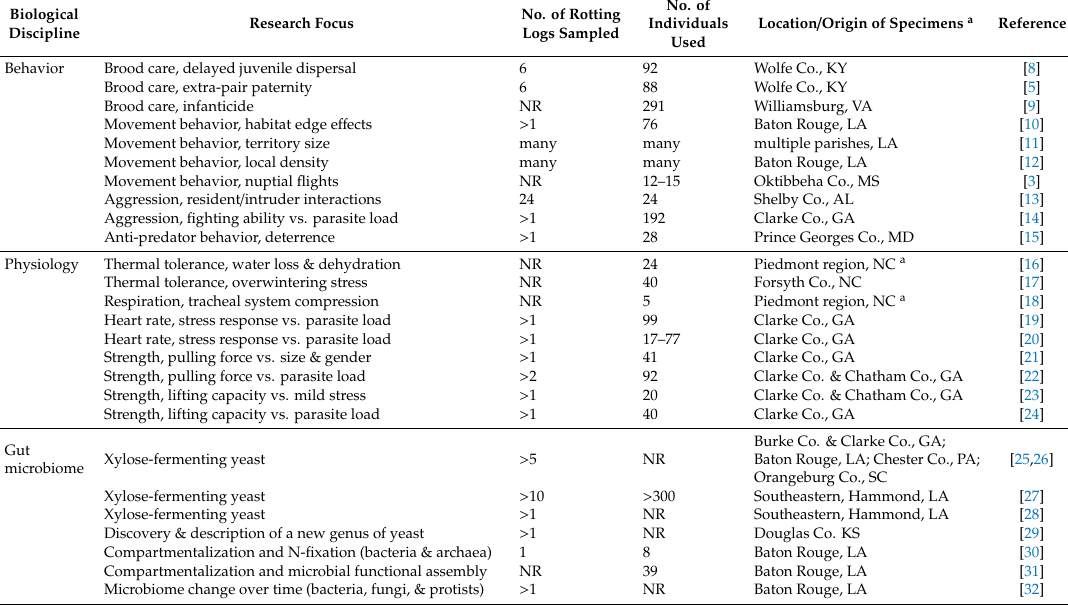
Table 1. Summary of published literature that used O. disjunctus as a model for insect behavior, physiology, and gut microbiome research. State abbreviations for geographic origins of specimens are as follows: Alabama (AL), Georgia (GA), Kansas (KS), Kentucky (KY), Louisiana (LA), Maryland (MD), Mississippi (MS), North Carolina (NC), Pennsylvania (PA), Southern Carolina (SC) and Virginia (VA); NR = not